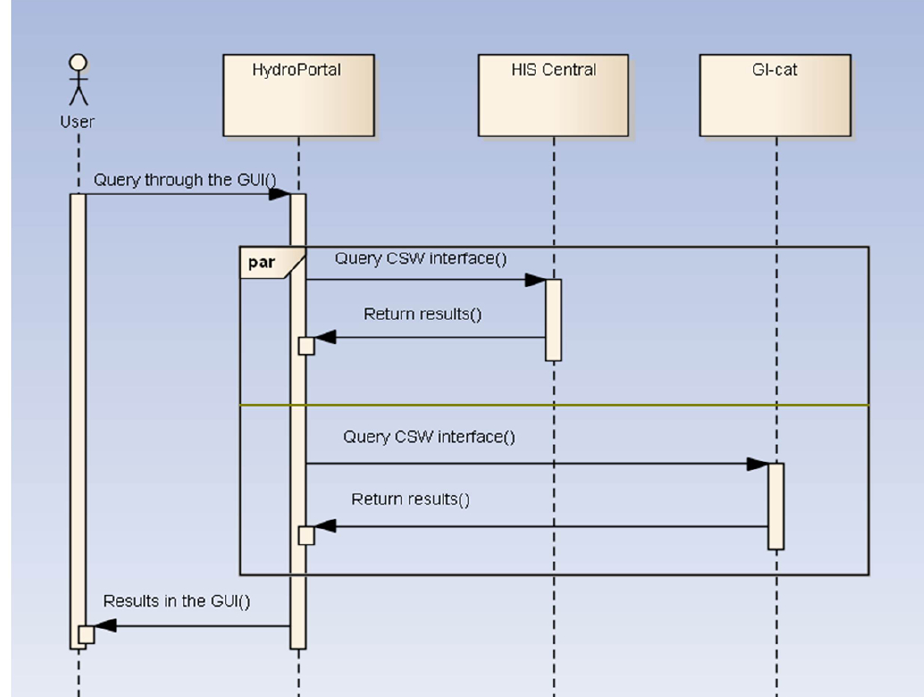
Fig. 17. Query time sequence diagram. HydroPortal, acting as a gateway, distributes the incoming query to the catalog services.